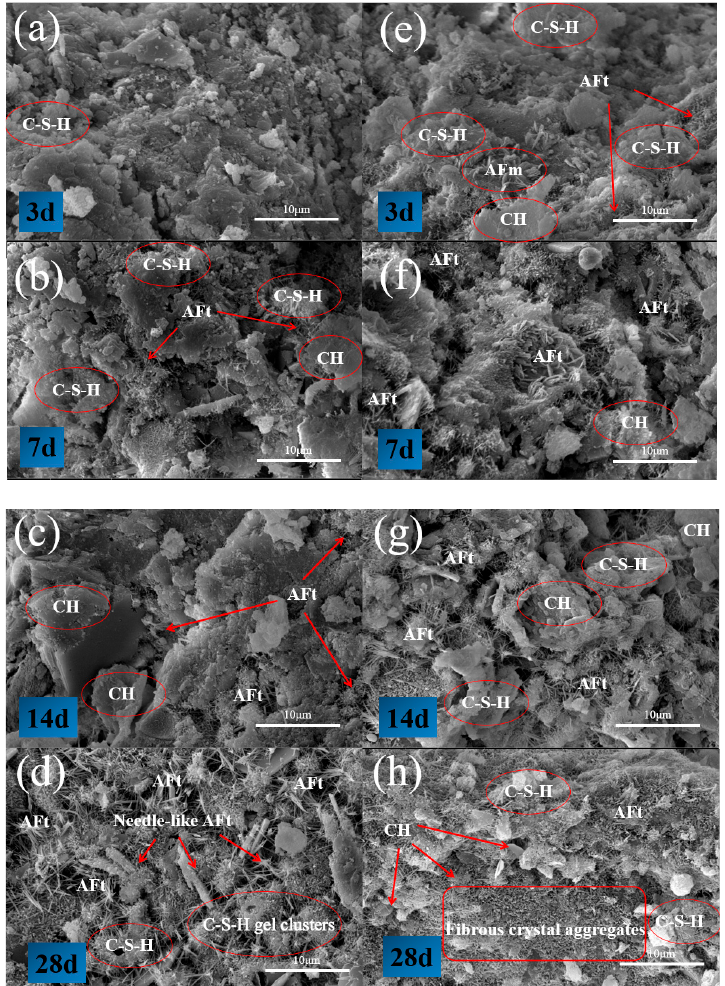
Figure 2. The mineral morphology of the ( a – d ) CP-R and ( e – h ) CP-2% paste samples at various curing ages.